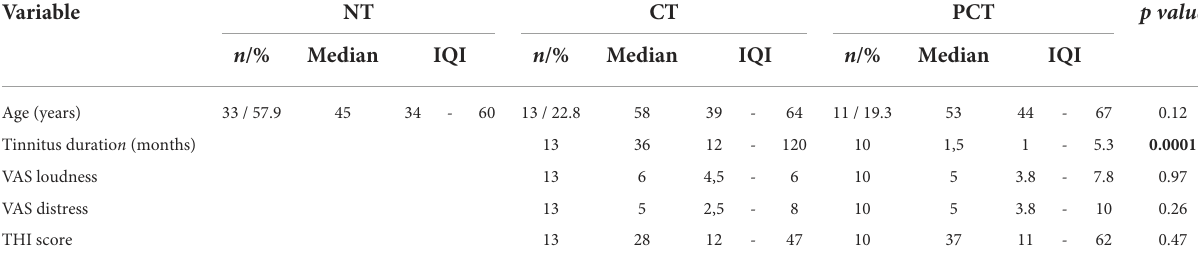
TABLE 1 Numerical variables for the whole sample ( n = 57).